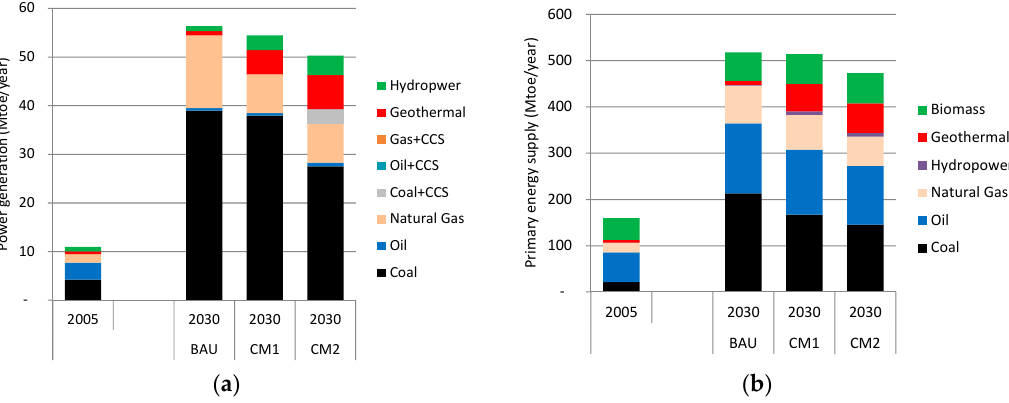
Figure 9. Electricity and primary energy supply by fuel type. ( a ) Electricity supply; and ( b ) primary energy supply. CCS: carbon capture and storage.